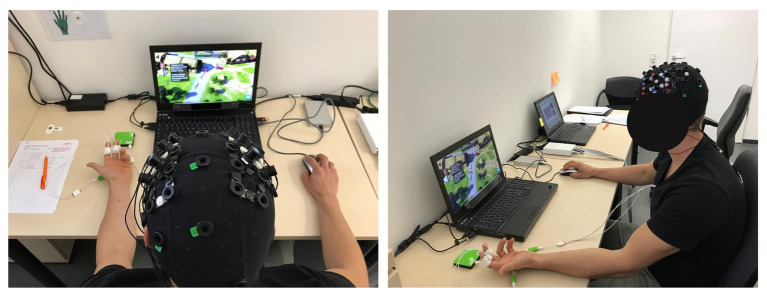
Experimental setup.